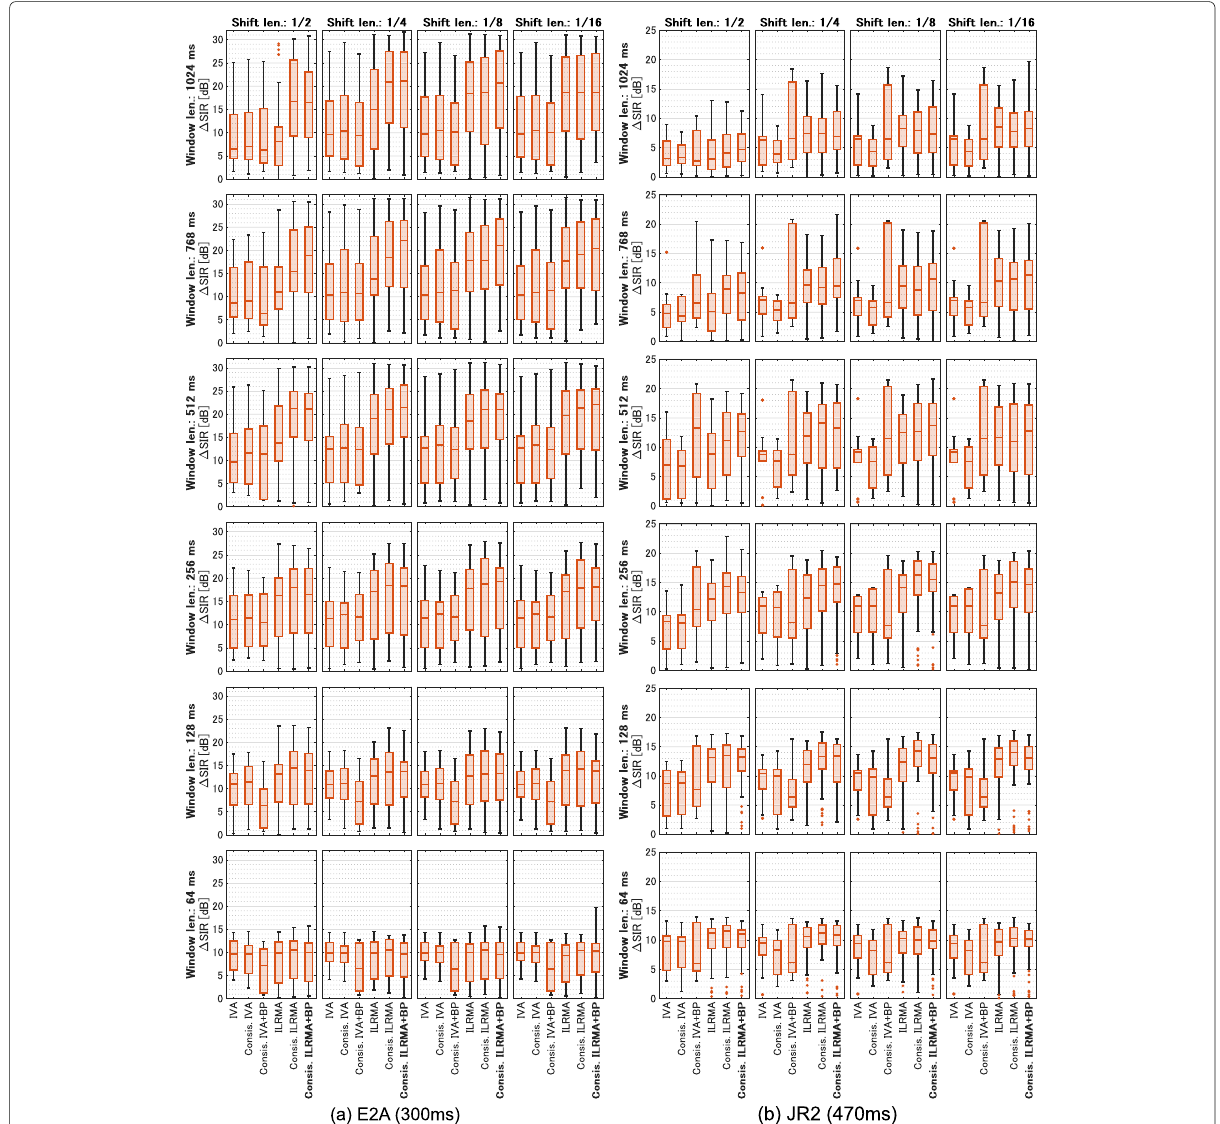
Fig. 18 Average SIR improvements for synthesized music mixtures (music 1–10) with a E2A and b JR2 , where Blackman window is used in